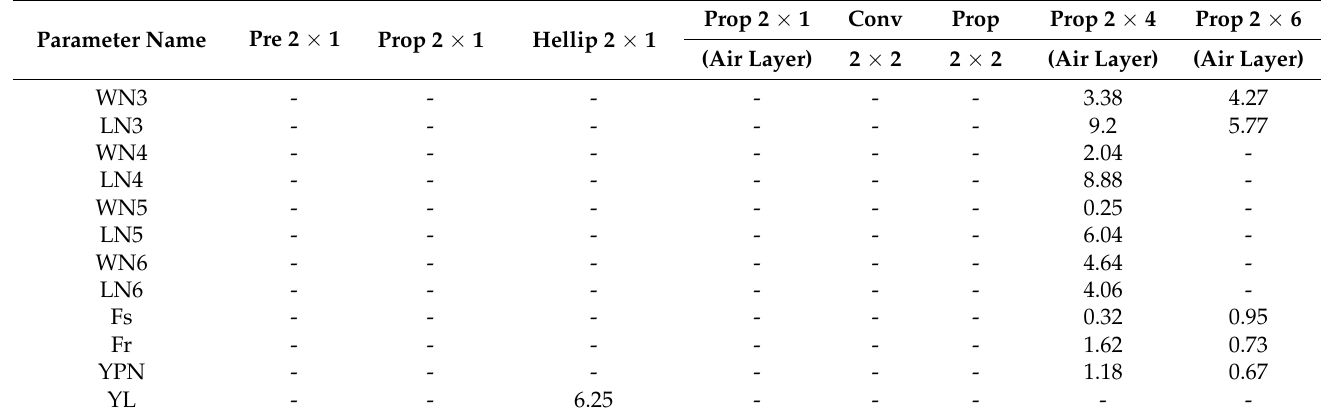
Figure 3. Simulated |S11|of the preliminary array, proposed array with rectangular bottom patch, and proposed array with two half elliptical patches. For the preliminary array, the miniaturized array with rectangular bottom patch, and the miniaturized array with two half elliptical patches, the − 10 dB bandwidths are 70 MHz (5.76 – 5.83 GHz), 320 MHz (5.59 – 5.91 GHz), and 300 MHz (5.59 – 5.89 GHz), respectively. The gains at 5.8 GHz are 7.2, 7.5, and 7.1 dBi. The aperture efficiencies at 5.8 GHz are 89%, 112%, and 100%, and the radiation efficiencies at 5.8 GHz are 77%, 83%, and 82%, respec- tively. It is worth pointing out that an aperture efficiency greater than 100 % just means that electrically the antenna is larger than its physical size [1].